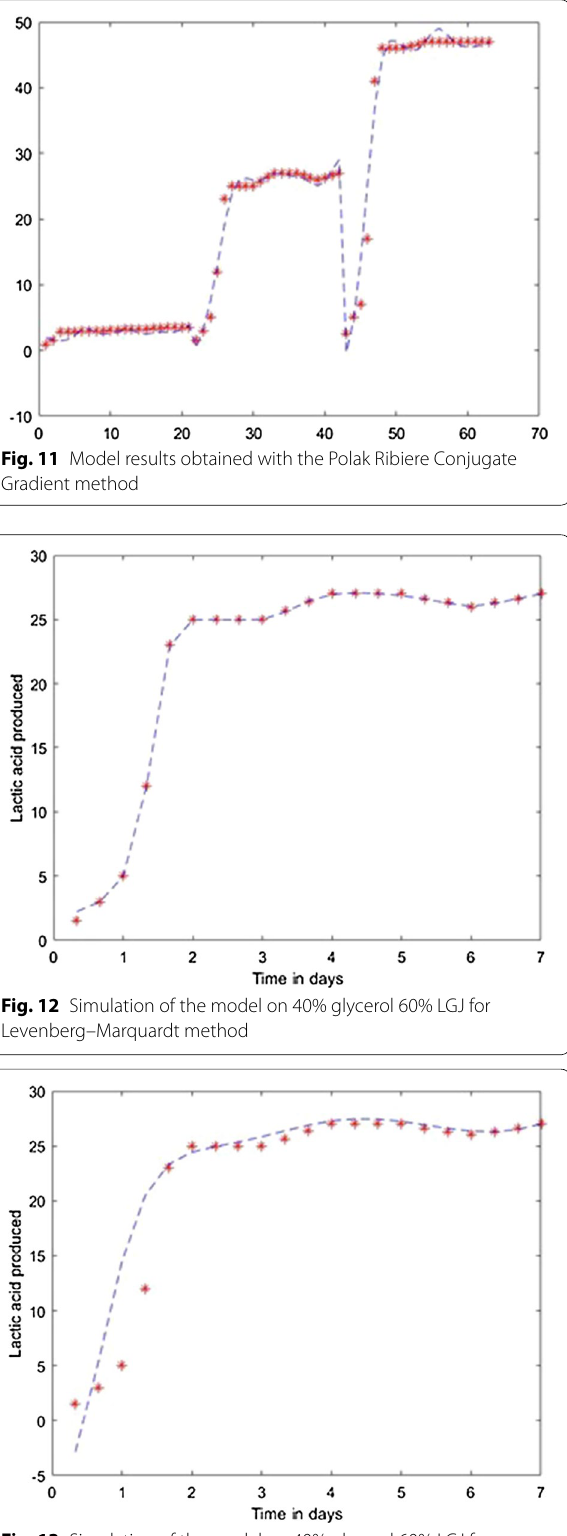
Fig. 13 Simulation of the model on 40% glycerol 60% LGJ for Quasi‑Newton method